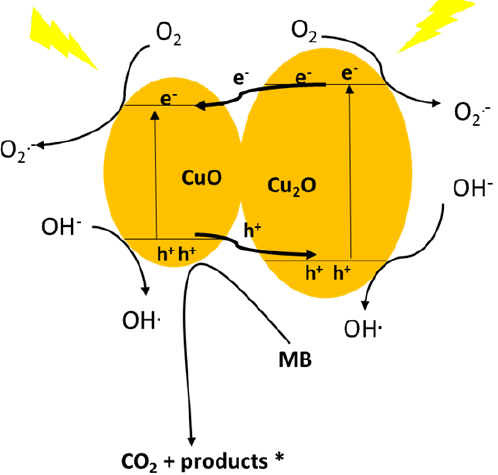
Figure 9. Proposed schematic illustration of the band structure related photocatalytic mechanism for the CuO – Cu 2 O heterojunction net.